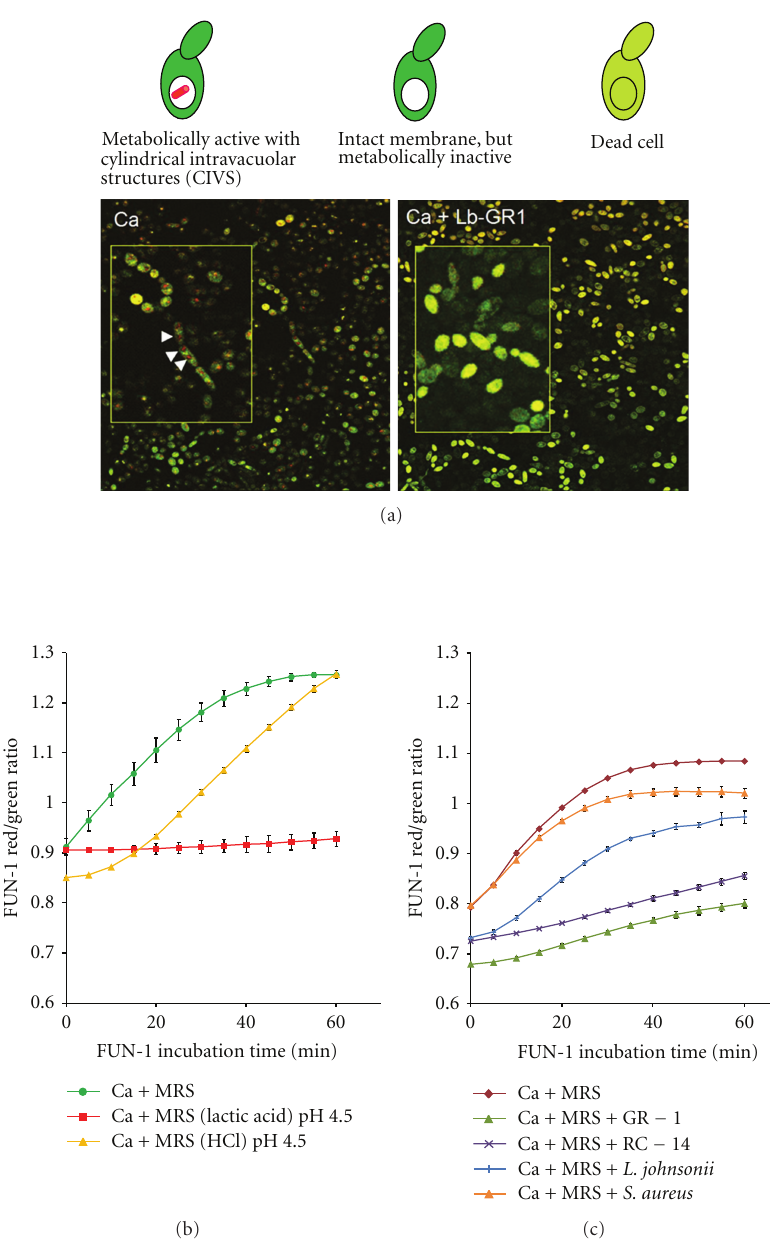
Figure 4: Viability assays of C. albicans cells following coculture with bacteria and exposure to lactic acid. (a) Microscopic viability assay: C. albicans cells were stained with the FUN 1 cell stain (Invitrogen) for viability after coculture with L. rhamnosus GR-1 (Ca + Lb-GR-1). A C. albicans culture without lactobacilli served as control (Ca). Cell images were obtained by confocal laser scanning microscopy. Results for the vital staining procedure are depicted above the images. White arrows in the zoomed insert image on the left indicate CIVS formation in metabolically active cells of the control culture. The presence of lactobacilli increases the number of metabolically inactive and dead cells (right image). (b) Fluorometric assay of C. albicans cells viability following 16 hr incubation in MRS, MRS (HCl) pH 4.5, and MRS (lactic acid) pH 4.5. Cell viability was measured by monitoring the conversion of FUN 1 to red fluorescent intravacuolar structures in a microplate assay. The red/green fluorescence ratio increases in the presence of viable, metabolically active cells, particularly within the first 30 min of the assay. Metabolically inactive cells show no increase of the red/green ratio. For assay details see Section 2. The figure shows the results of a representative experiment. Incubation of C. albicans cells in MRS at pH 4.5 in the presence of lactic acid appears to reduce cell viability much more than incubation in MRS that was adjusted to pH 4.5 using HCl. (c) Example of a fluorometric FUN 1 cell viability assay of C. albicans following coculture with L. rhamnosus GR-1, L. reuteri RC-14, L. johnsonii , or S. aureus . A C. albicans culture without bacteria served as control (Ca + MRS). GR-1 and RC-14 consistently caused the strongest reduction in C. albicans viability. All fluorometric experiments were conducted in triplicate. Error bars indicate standard